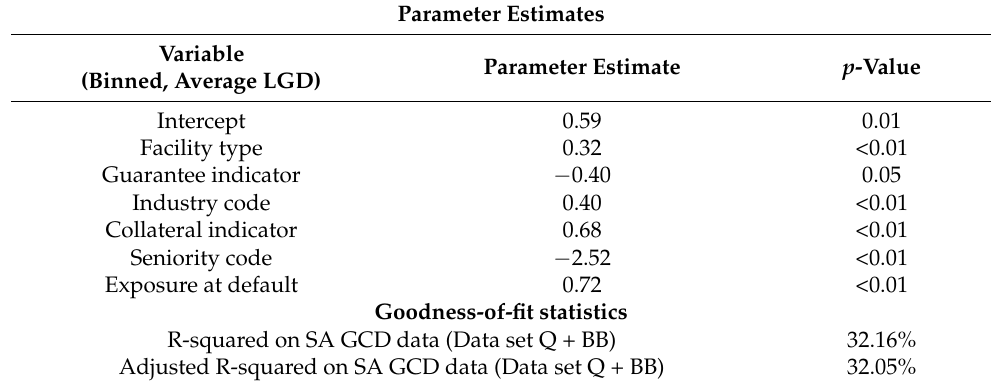
Table 4. Regression results of the SA GCD data (Data set Q + BB).